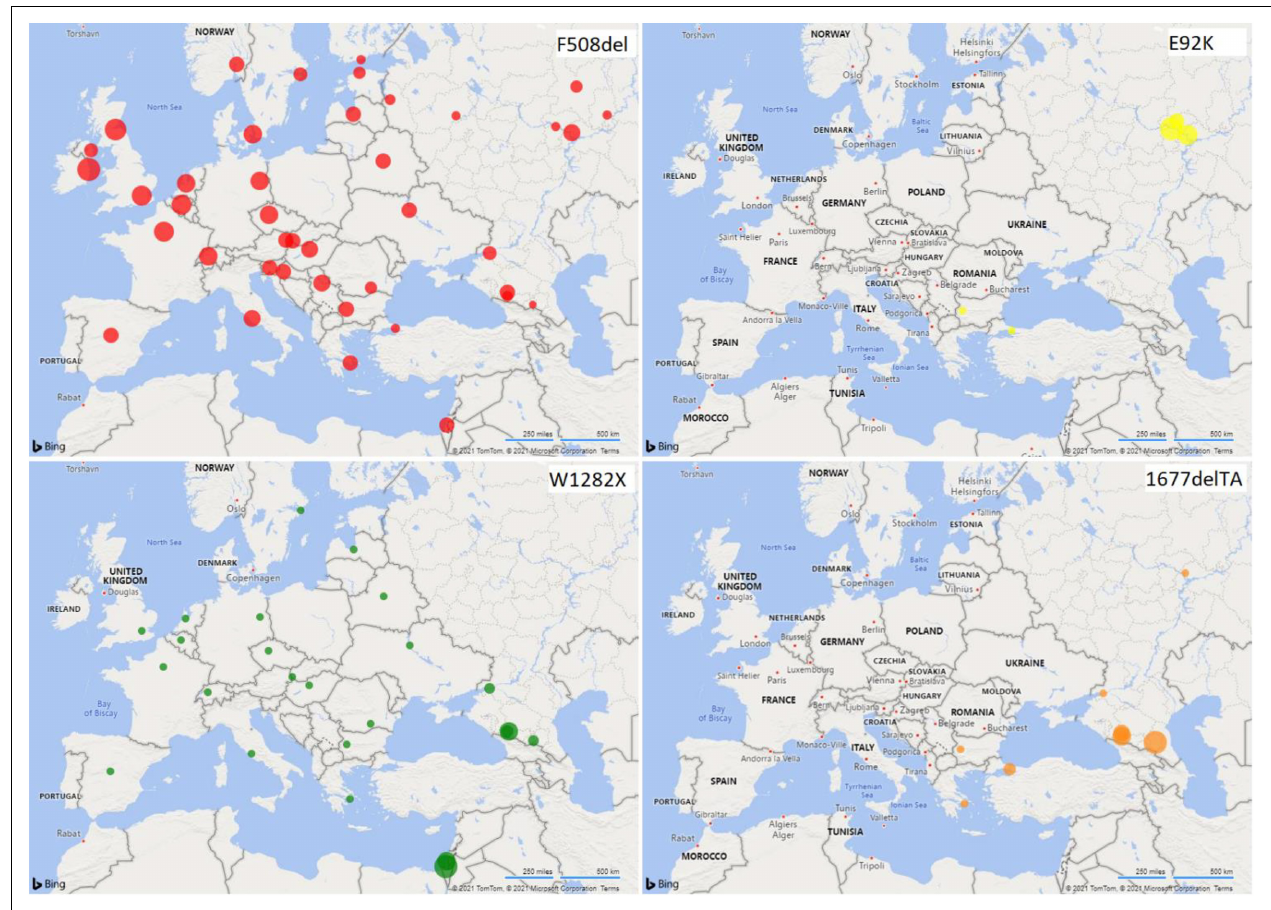
FIGURE 3 | Distribution of CFTR variant frequencies in European populations. The radii of the circles reflect the frequency values.